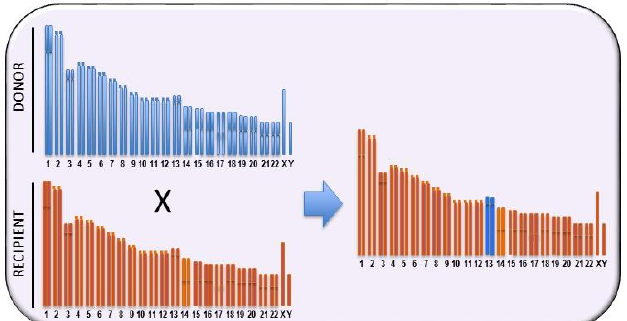
Figure 2. Schematic representation of the generation of an inbred consomic strain, i.e., containing a single entire chromosome from a donor strain, by backcrossing to a parental inbred strain for at least ten generations while selecting for the maintenance of a specific whole chromosome from the donor